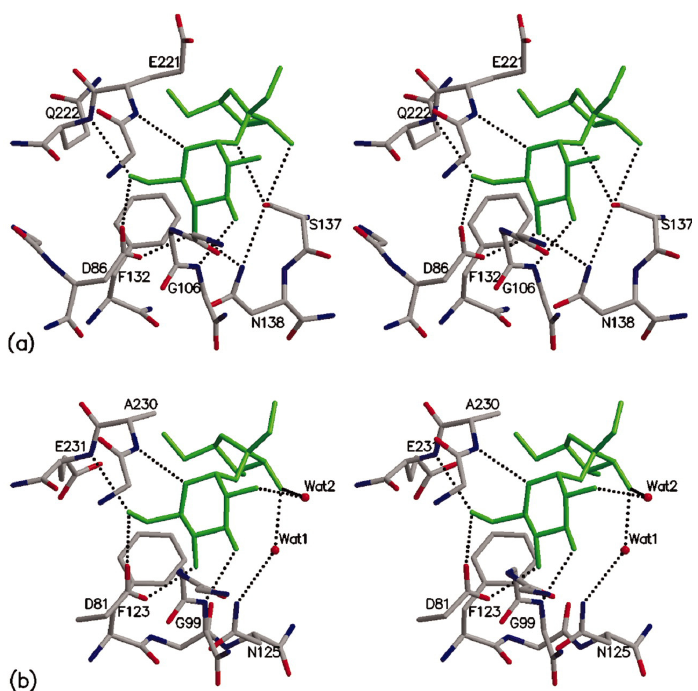
Figure 9. Binding sites of sucrose in PAL and lentil lectin. ( a ) omplex of sucrose with PAL. ( b ) equiva- lent complex with lentil lectin shown in the same orientation. Figure taken from reference